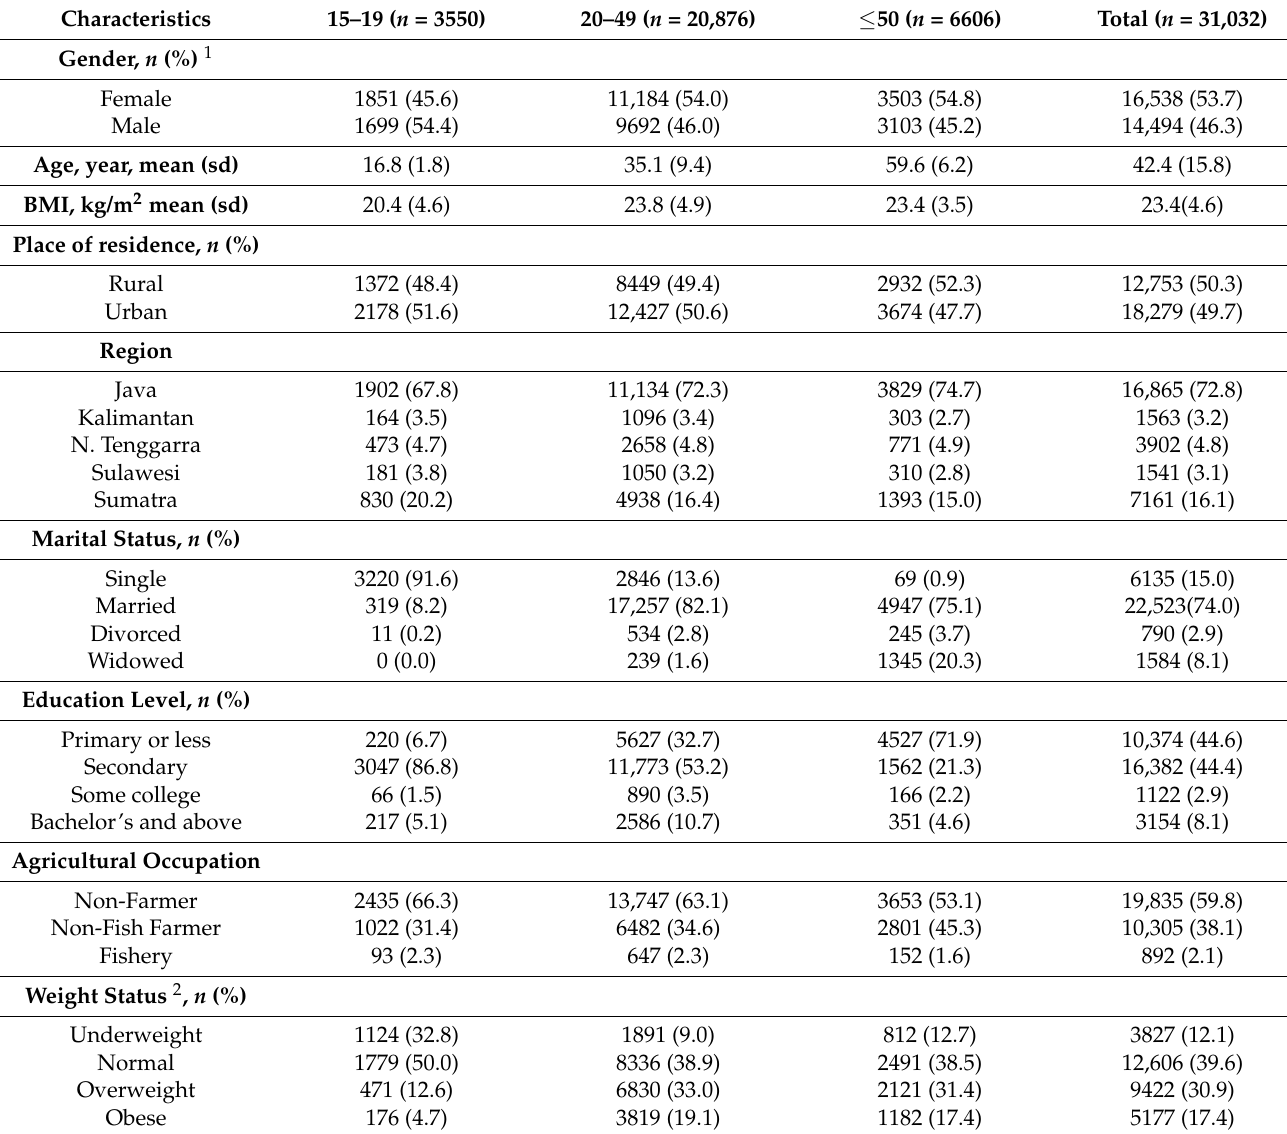
Table 1. Characteristics of study respondents in IFLS 5 stratified by age group.